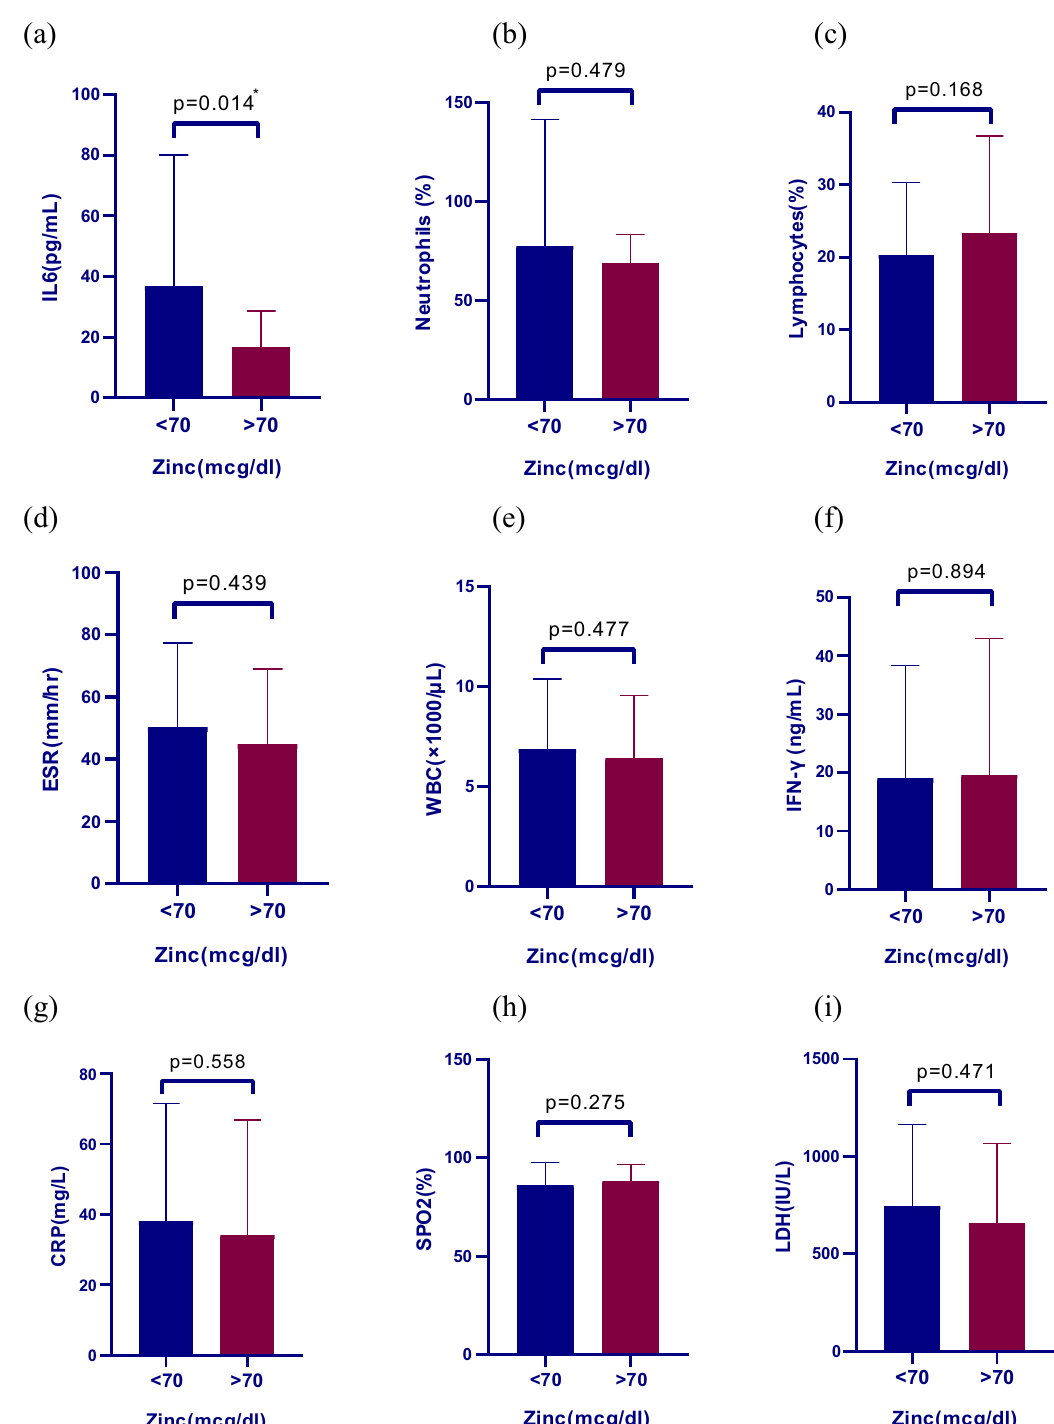
Figure 1: Comparison of in fl ammatory factors in two subgroups of serum zinc ( less and more than 70mcg/dL ) . ( a ) Serum zinc and IL - 6 ( pg/mL. ( b ) Serum zinc and neutrophils ( % ) . ( c ) Serum zinc and lymphocytes ( % ) . ( d ) Serum zinc and ESR ( mm/h ) . ( e ) Serum zinc and WBC (× 1,000/µL ) . ( f ) Serum zinc and IFN - γ ( ng/mL ) . ( g ) Serum zinc and CRP ( mg/L ) . ( h ) Serum zinc and SpO